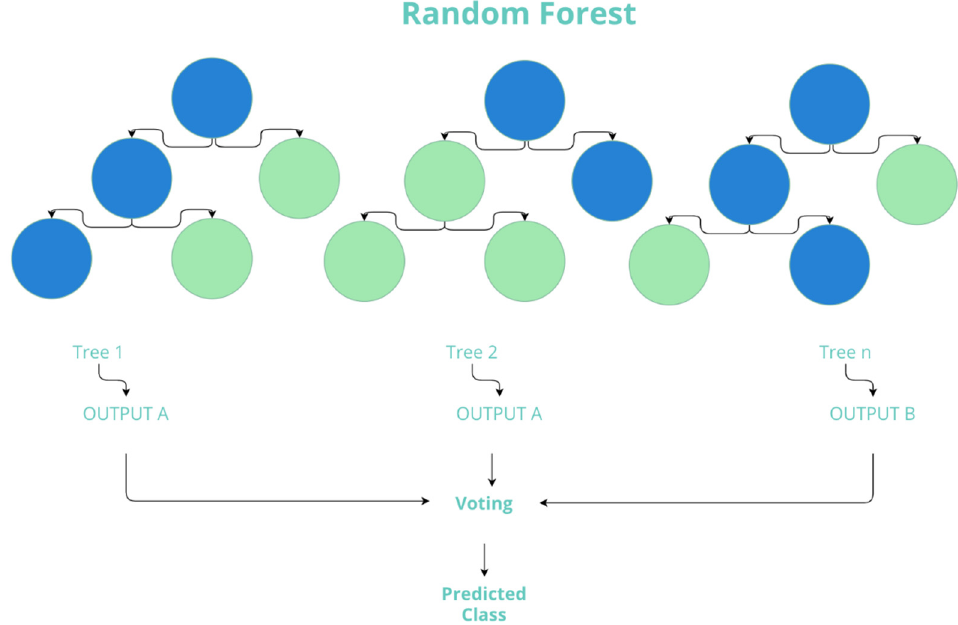
Figure 2. Diagram of the Random Forest algorithm. The algorithm generates multiple trees; in the figure, each set represents a tree. Each tree classifies a class, resulting in the class with the highest number of votes.